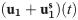
Schematic diagram illustrating the system discussed in the text.The locations of two nearby particles, labelled 1 and 2, are located at x1(t) and x2(t) respectively, with turbulence velocities u1(t) and u2(t), at time t; their separation is l(t) = |x2 − x1|. They are transported with velocities (u1+u1s)(t) and (u2+u2s)(t) respectively to the new locations x1s(t) and x2s(t) at the next time step t + dt, as shown.